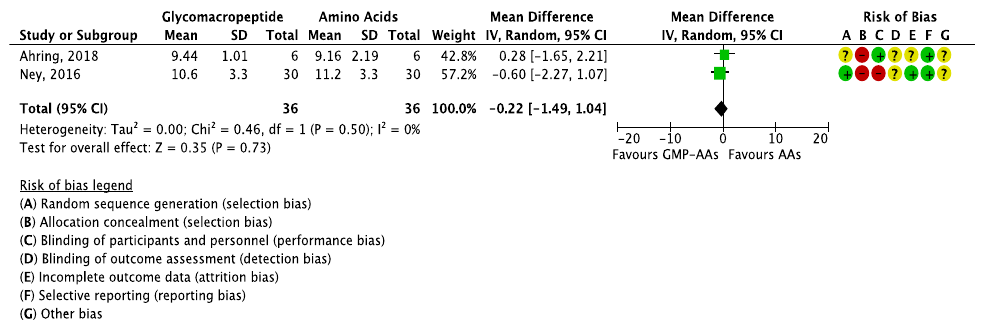
12 of 17 Figure 5. Forest plot of studies with data on glycomacropeptide interventions on blood tyrosine levels. The analysis included data from two studies with a total of 72 participants.AAs: synthetic protein derived from L-amino acids; CI: confidence interval; df: degrees of freedom; GMP-AAs: glycomacropeptide supplemented with amino acids; IV: intravitreal; SD: standard deviation. The meta-analysis for BUN reported no significant differences between GMP-AAs and AAs (MD